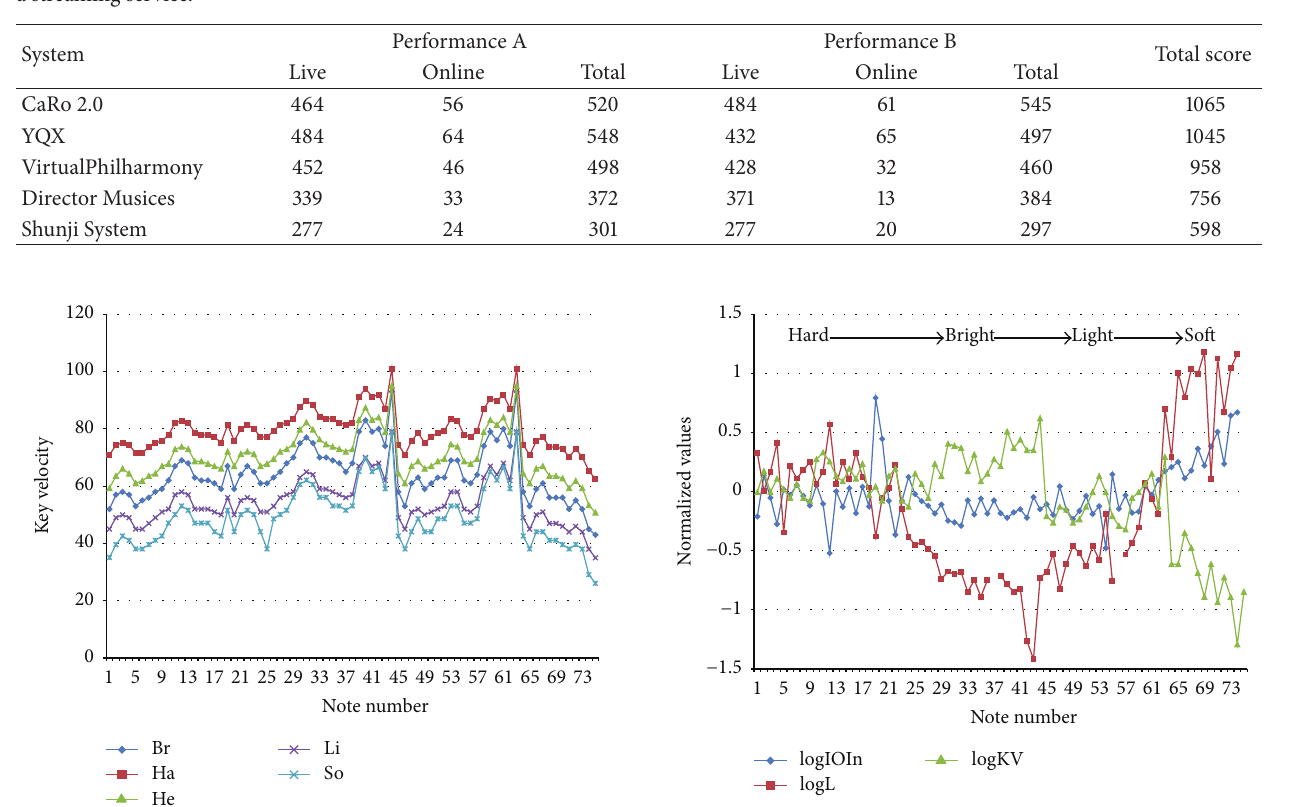
Figure 14: The values of the three main expressive parameters of the performance obtained drawing the trajectory of Figure